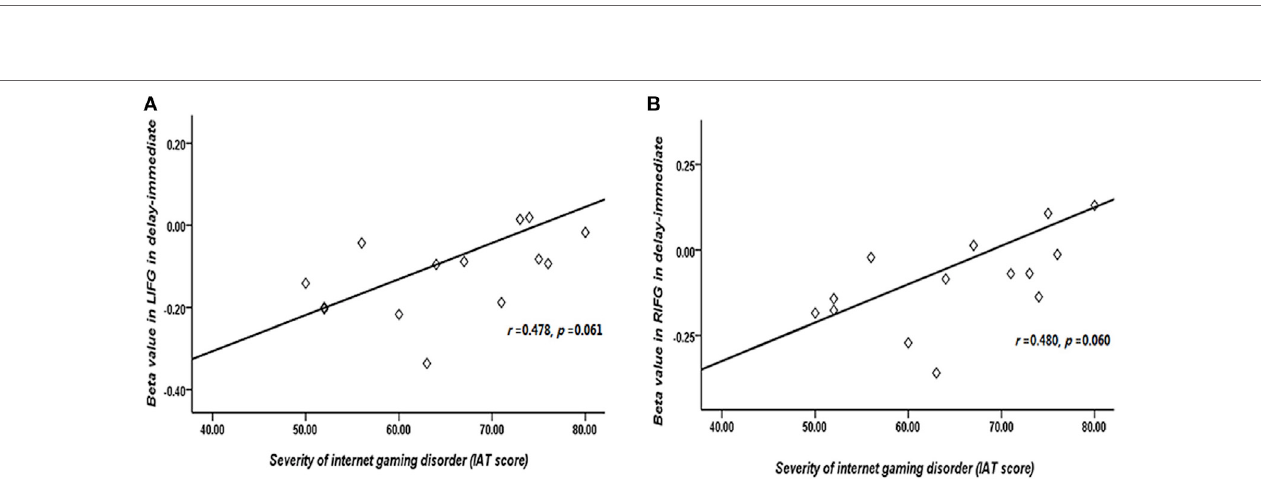
FigUre 6 | Positive correlations between the brain activations in the dorsolateral prefrontal cortex (DLPFC) and bilateral inferior frontal gyrus (IFG) and log k in both